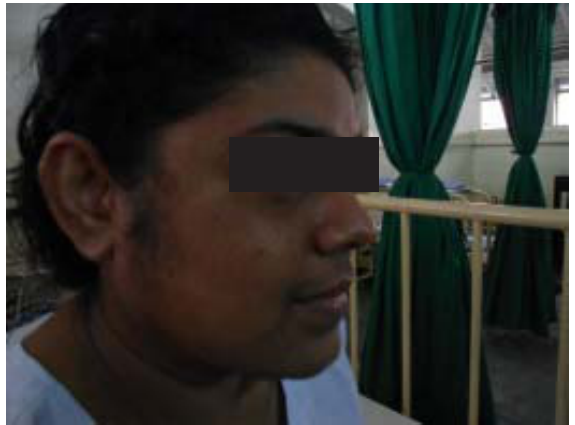
Figure 2. Hirsutism, downy sideburns and in- creased hair on the upper lip and under the chin.